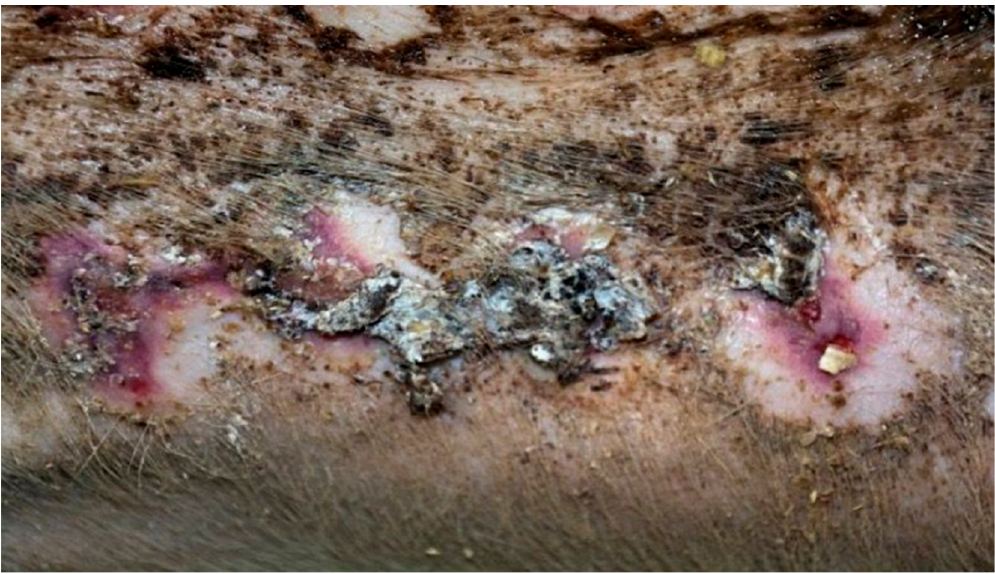
Figure 12. Group K—burn wound treated with sulfathiazole on day 25.